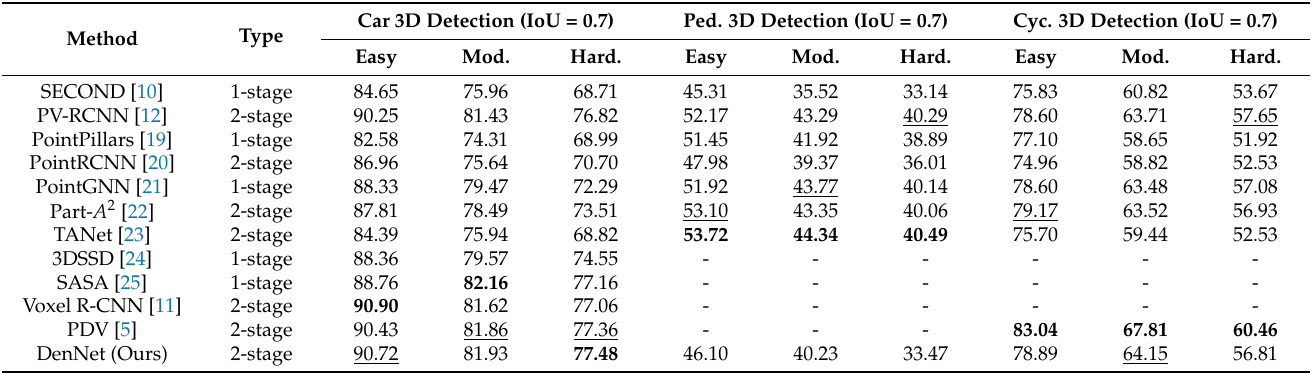
Table 1. Performance comparison on the KITTI test set. All results were evaluated based on the mean average precision with 40 recall positions via the official KITTI evaluation server. The best results are presented in bold, whereas the second-best results are underlined.